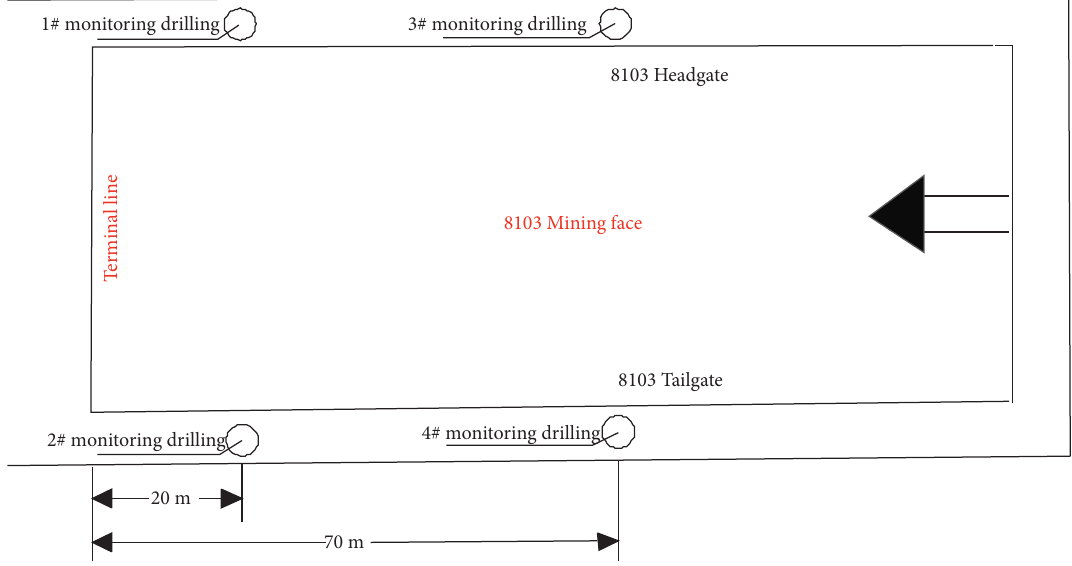
Figure 14: Drilling position design drawing.